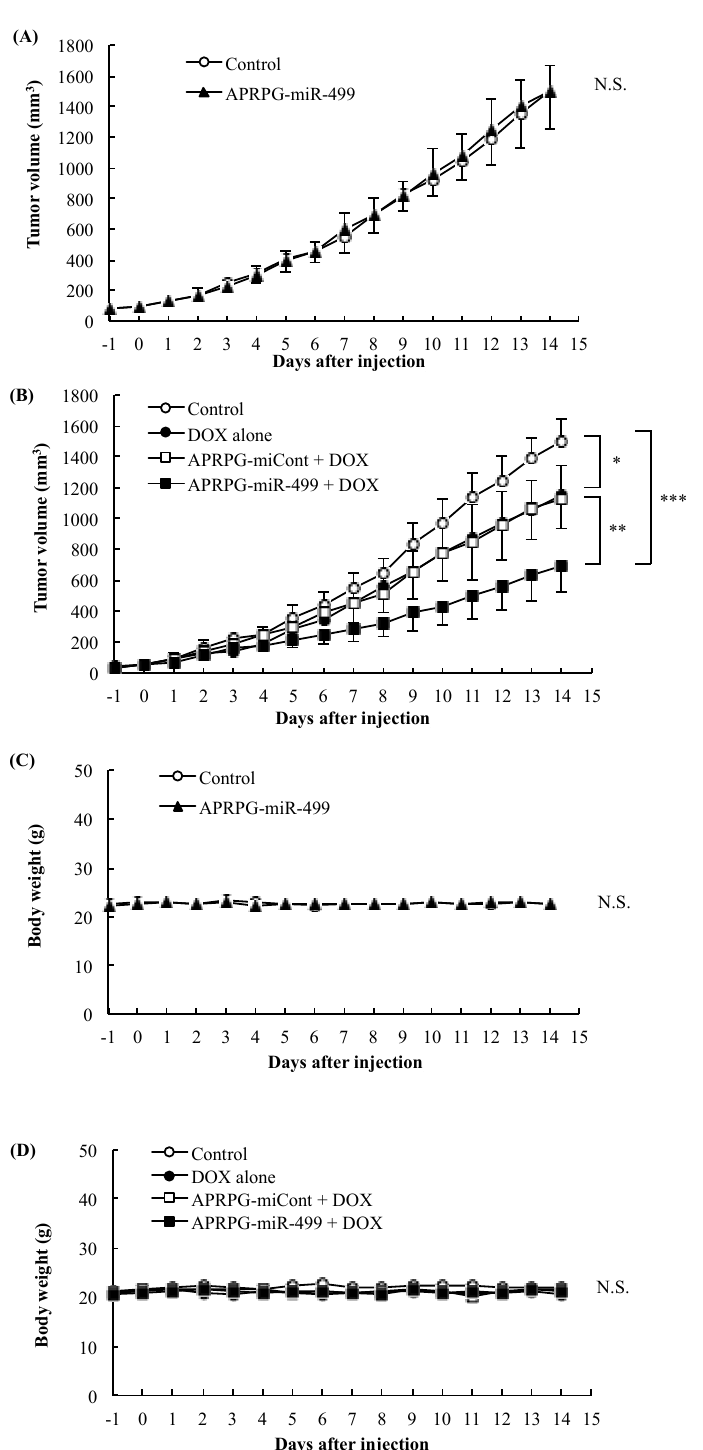
Figure 3. Combination therapy with miR-499 and DOX. Colon 26 NL-17 cells were subcutaneously implanted into the left posterior flank of BALB/c mice. APRPG-miR-499 was administered intravenously when the tumor volume had reached 50 mm 3 . In the case of combination therapy, DOX (5 mg/kg) was intravenously injected via a tail vein at four days after the lipoplex injection. The tumor size ( A , B ); and body weight ( C , D ) of each mouse were monitored daily from one day before lipoplex injection. Asterisks indicate significant differences (* p < 0.05, ** p < 0.01, *** p < 0.001). N.S. means no significant difference.